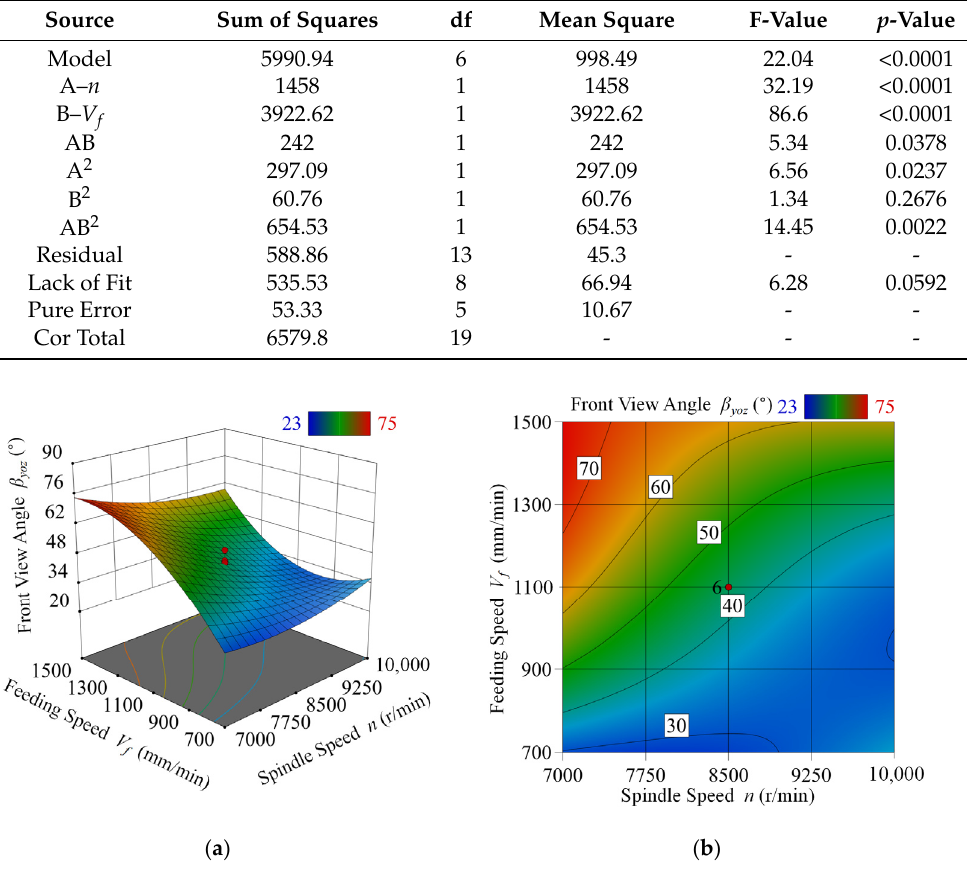
Figure 6. Feed rate V f and spindle speed n versus orthogonal diffusion angle β yoz at depth of cut a c = 10 mm. ( a ) Plot of the response surface of the orthogonal diffusion angle β yoz with respect to spindle speed n and feed rate V f . ( b ) Contour plot of the response surface.